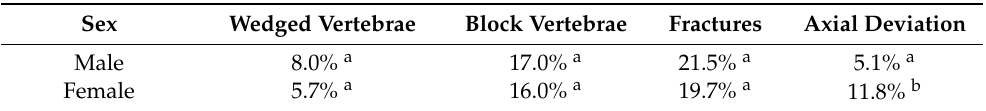
Table 8. LSMeans for the probability of occurrence of wedged vertebrae, block vertebrae, fractures, and axial deviations in the tail region of lambs by sex. Significant differences ( p < 0.05) are marked with different superscript